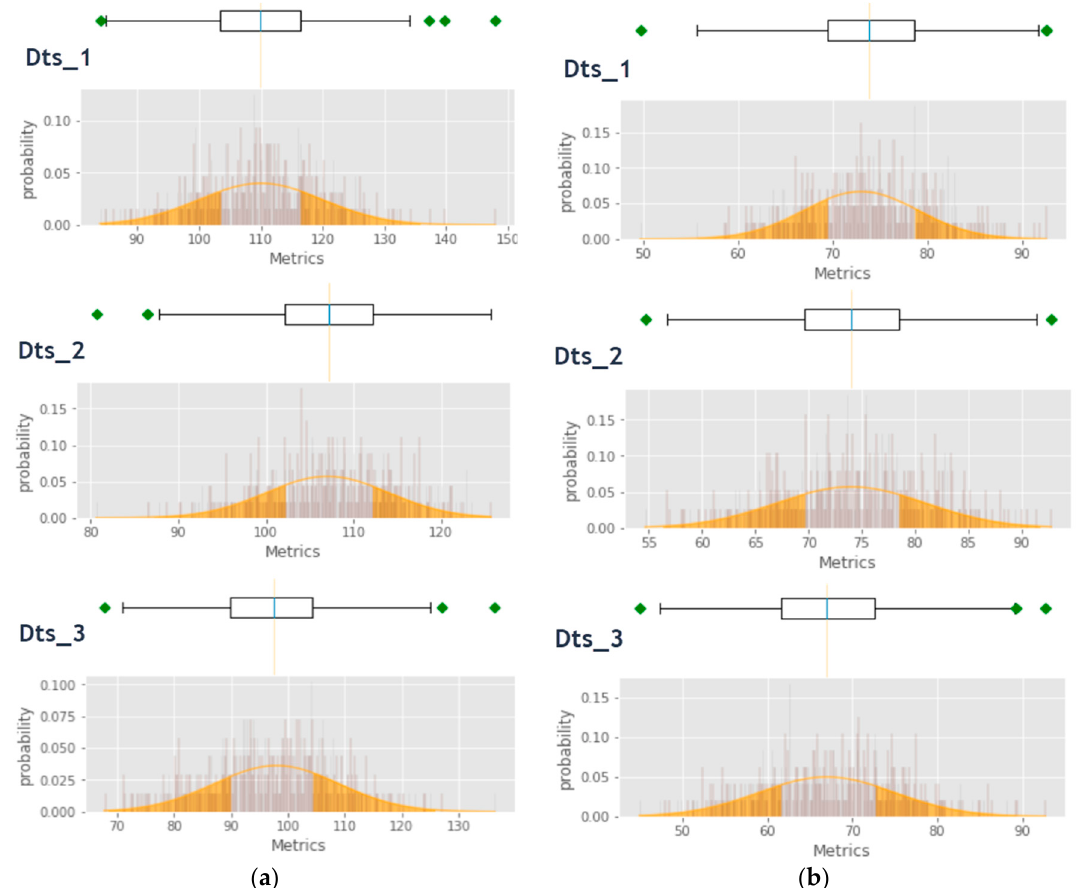
Figure 13. ( a ) Anomalies area within the normal distribution of the Sys measures and ( b ) anomalies area within the normal distribution of the Dias measures.